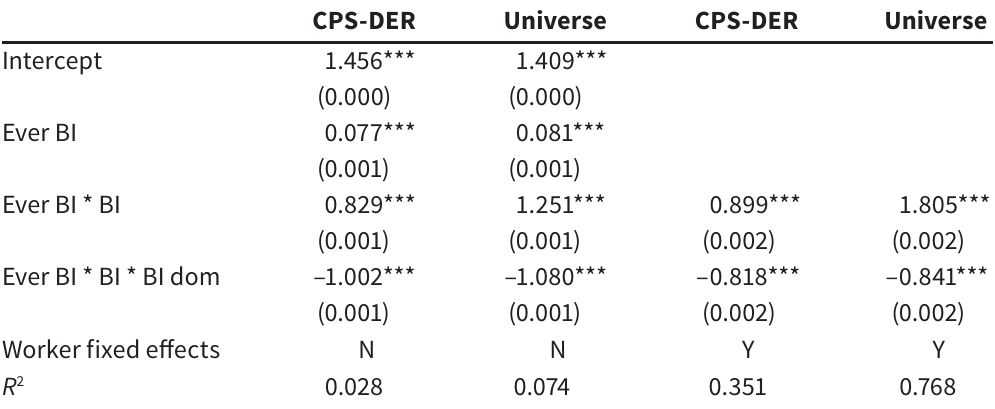
Table G3 Regression of total number of jobs worked on BI, by dominant earnings CPS-DER Universe CPS-DER